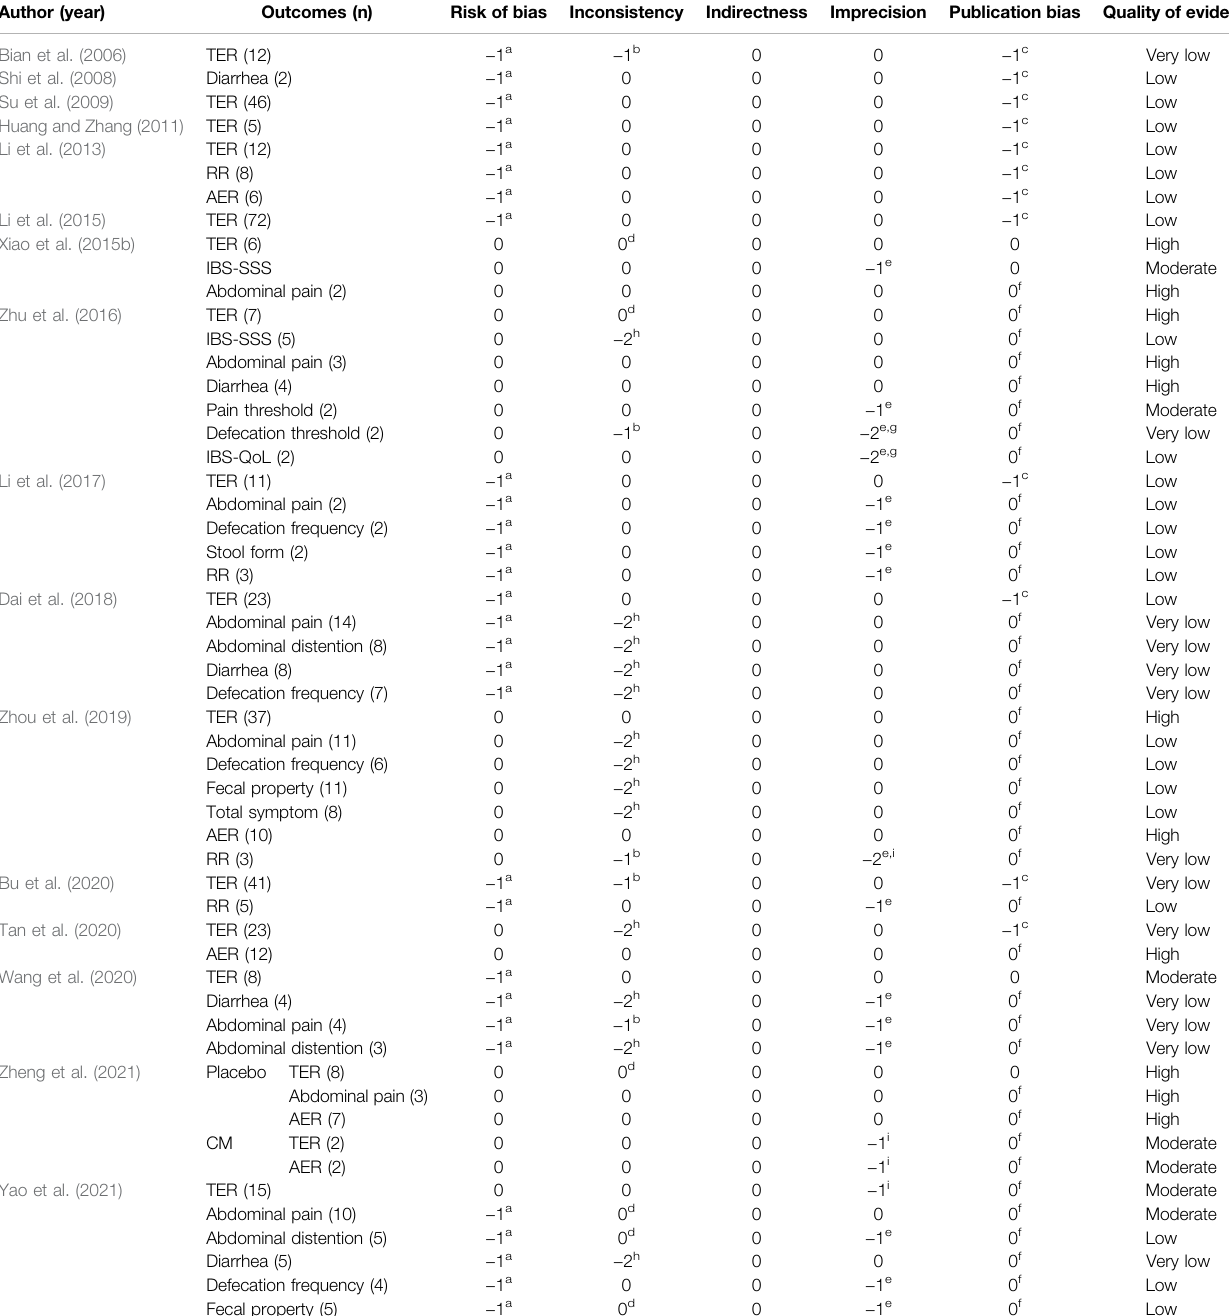
TABLE 5 | Quality of evidence in the included systematic reviews based on